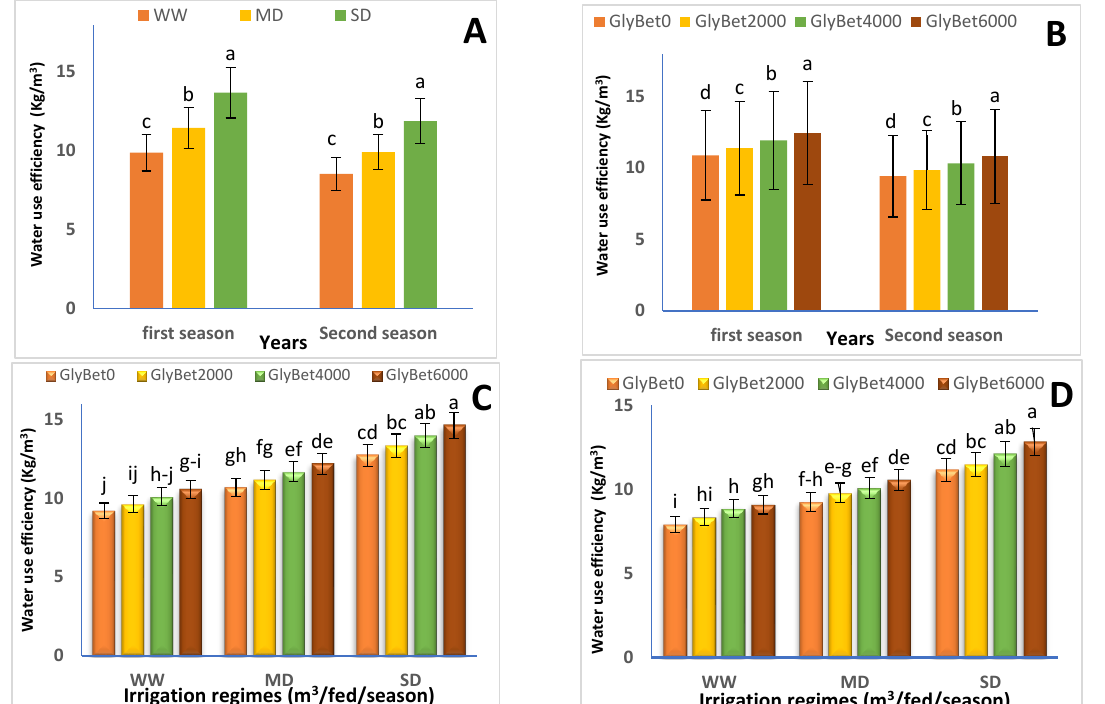
Figure 1. Water use efficiency of cucumber plant as affected by irrigation regimes ( A ), glycinebetaine concentration ( B ), and their interactions ( C , D ) in both seasons — 2020 and 2021. WW — well-watered (1250 m 3 /fed); MD — moderate drought (950 m 3 /fed); SD — severe drought (650 m 3 /fed); fed — feddan. Values followed by the same lower-case letter are not significantly different following Tukey’s HSD at p ≤ 0.05